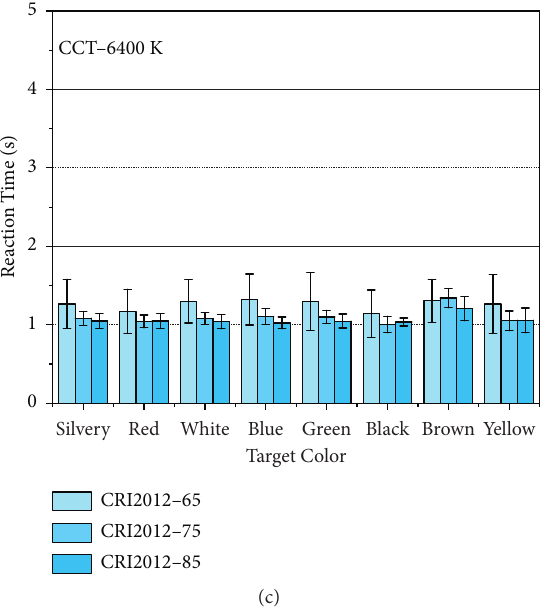
Figure 18: The reaction time of all observers under different CRI2012s and CCTs.